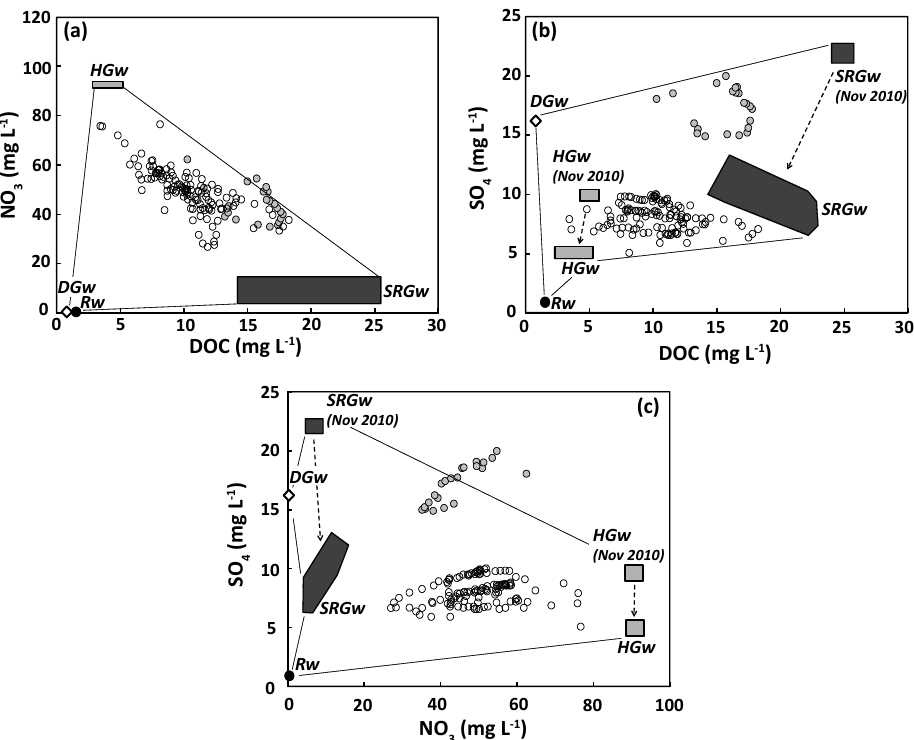
Figure 6. End-member mixing diagrams for the six investigated storm events: (a) NO 3 versus DOC; (b) SO 4 versus DOC; (c) SO 4 versus NO 3 . Data from event no. 1 on 11 November 2010 shown as solid grey circles. Rw: rain water; DGw: deep groundwater; SRGw: shallow riparian groundwater; HGw: hillslope groundwater. Filled areas for SRGw and HGw delimit the changes in concentration observed for these two end-members during the study period. Data source: Lambert et al. (2013); Lambert, unpublished